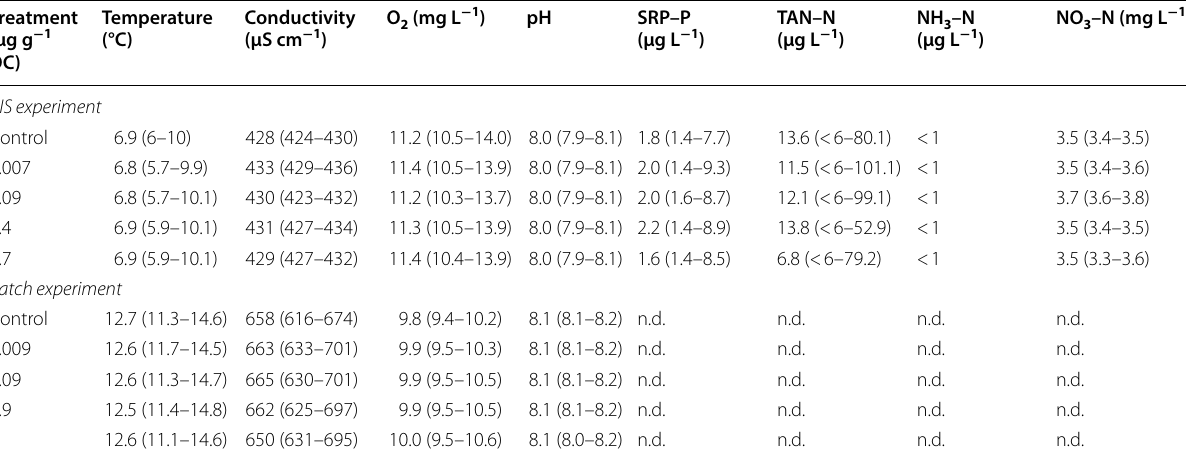
n.d. not determined